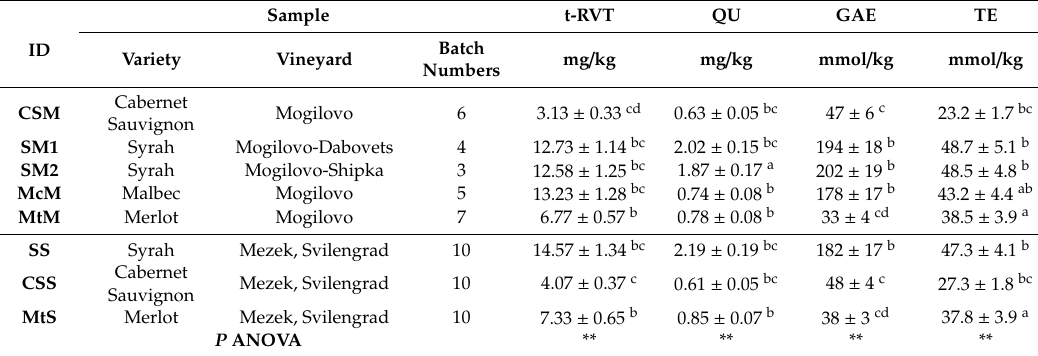
Table 1. Results * of antioxidant parameters of red wine grapes, vintage